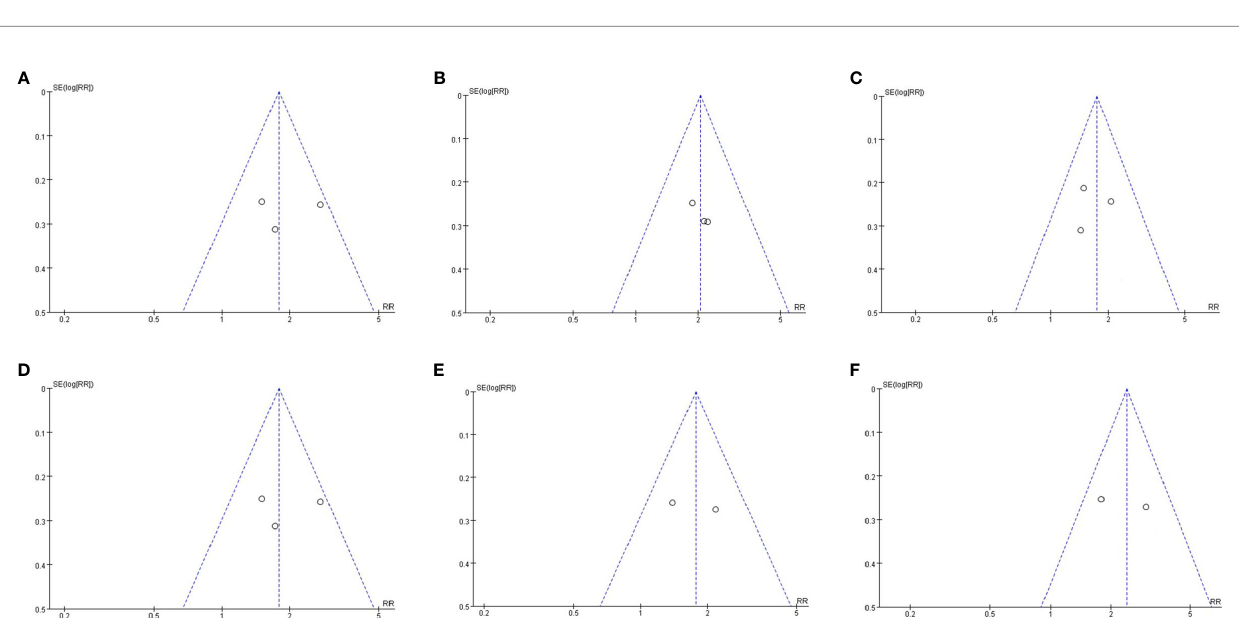
FIGURE 7 | Publication bias assessment. (A) Funnel plots for hepatic histologic scores(steatosis grade); (B) Funnel plots for hepatic histologic scores(In fl ammation grade); (C) Funnel plots for hepatic histologic scores(ballooning grade); (D) Funnel plots for hepatic histologic scores( fi brosis stage); Funnel plots for resolution of NASH (E) ; Funnel plots for reduction of at least 2 points in hepatic histologic scores (F)